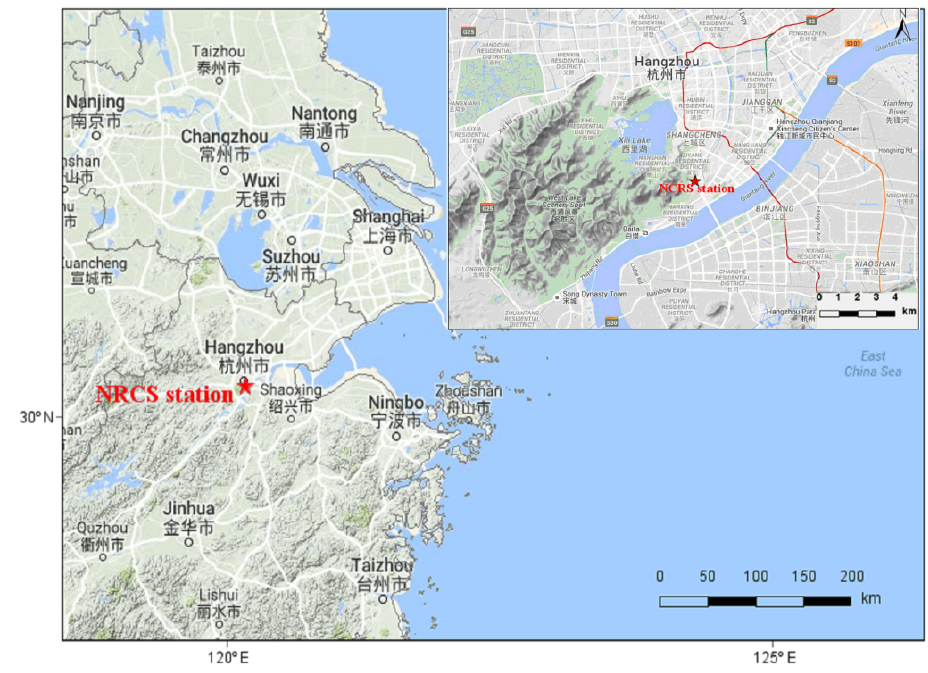
Figure 1. Location of the NRCS in the YRD region (left) and in the city of Hangzhou (top